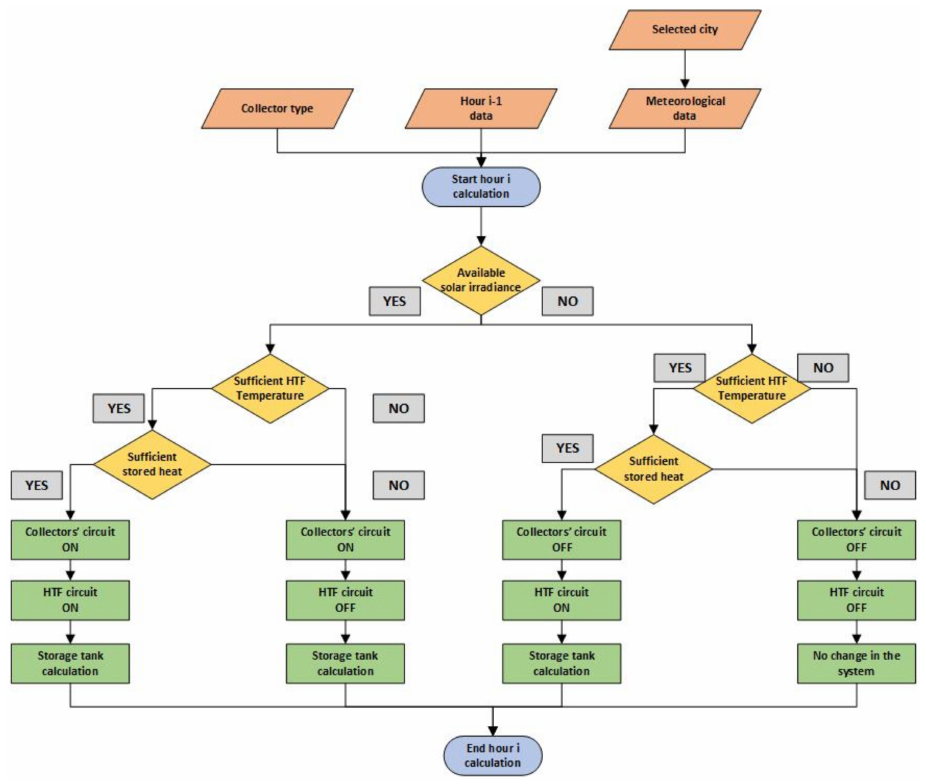
Figure A1. Flowchart of the solar subsystem modeling